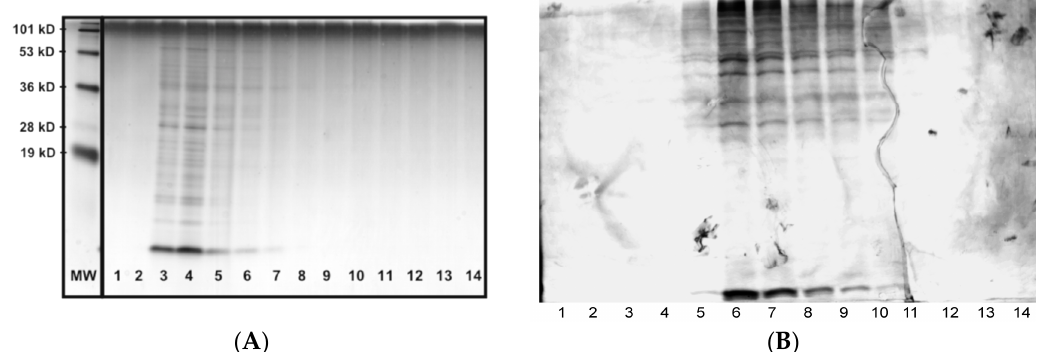
Figure 1. Gel filtration of SV extracts and whole cell lysates. Panel ( A ) represents the elution profile (1 mL fractions, 10 mL Sephadex 100 column) of SVs, and Panel ( B ) represents the elution profile (1 mL fractions, 10 mL Sephadex 100 column) of a whole cell lysate. Lanes were loaded with 1 µL of sample and analyzed by SDS–PAGE on 16.5% Tris–Tricine gels, followed by silver staining. Lanes 1 and 2 represent the void volume. MW represents the approximate location of various molecular weight marker bands.